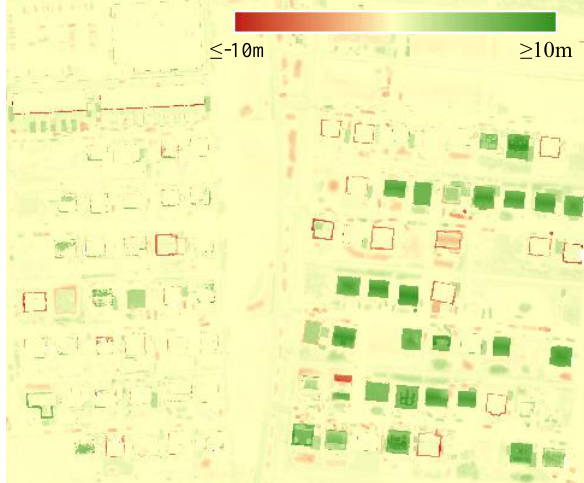
Figure 3: DSM difference between 1st and 3rd epoch (5 months)